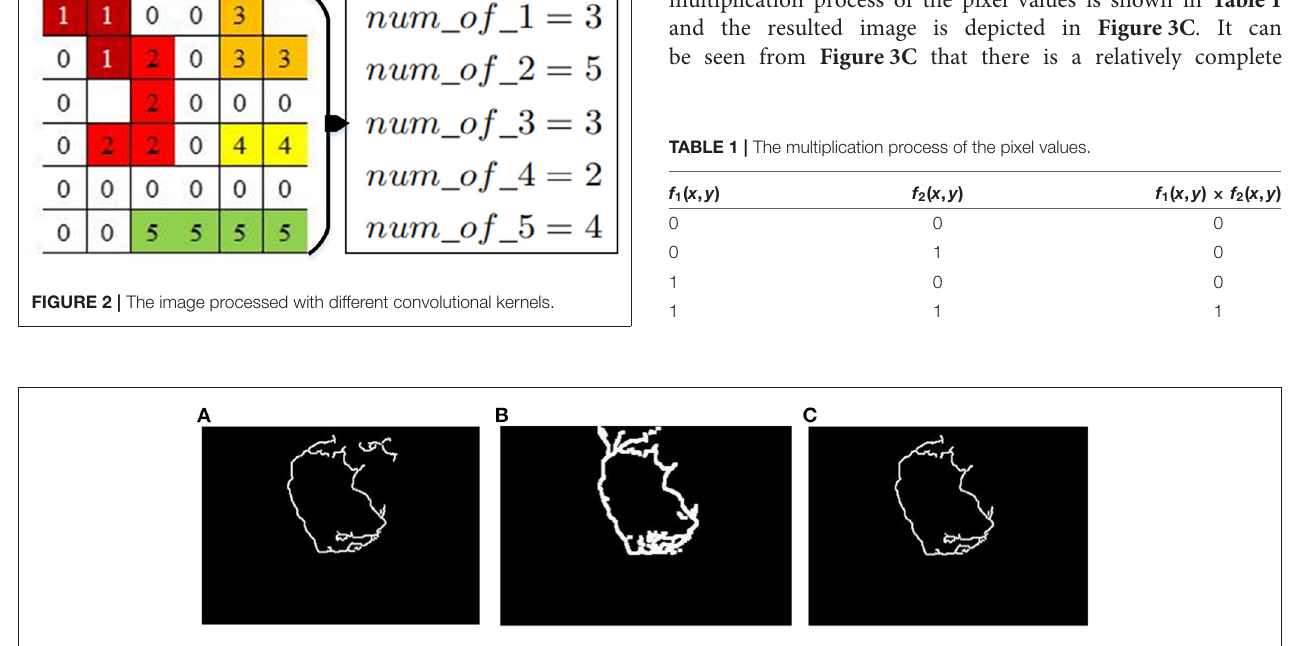
FIGURE 3 | The illustration of the continuous pixel labeling. (A) The image processed with a 4 × 4 convolutional kernal. (B) The image processed with a 6 × 6 convolutional kernal. (C) The processed image with double channel convolutional kernal.